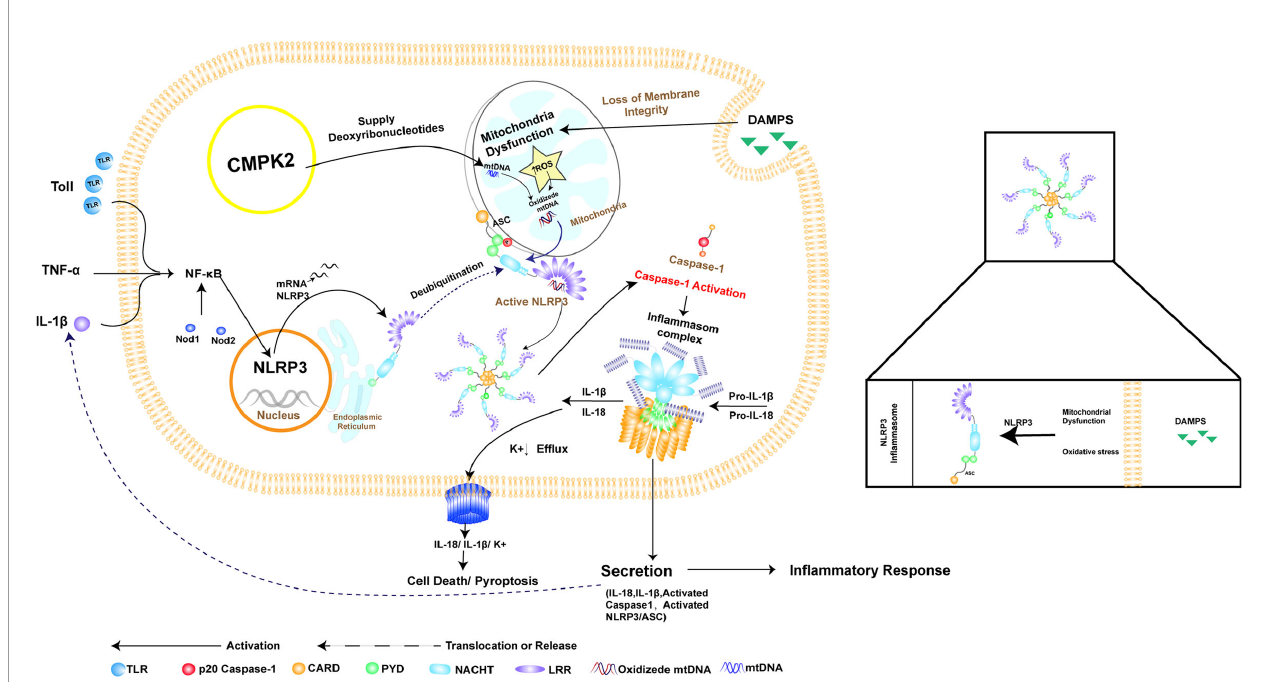
FIGURE 1 | The relationship between NLRP3 in fl ammasome activation and CMPK2. NLRP3 consists of PYD, NACHT, and LRR domains, which recruit the joint protein ASC and downstream pro-caspase-1 to form the in fl ammasome. Assembly and activation of the NLRP3 in fl ammasome require mitochondrial damage, which results in the release of fragmented mtDNA and increased production of reactive oxygen species (ROS), resulting in oxidation of mtDNA (OX-mtDNA). Activation of the NLRP3 in fl ammasome involves pathogen-related or damage-associated molecular patterns (damPs), which are directly involved in toll-like receptor (TLR) activation, leading to rapid activation of NF- k B and induction of mitochondrial DNA (mtDNA) synthesis. Oxidized mtDNA is associated with the NLRP3 in fl ammasome complex. CMPK2 is a rate-limiting enzyme that provides deoxyribonucleotides for mtDNA synthesis, thus playing a key role in NLRP3 activation and the downstream in fl ammatory response. This graphic was generated using